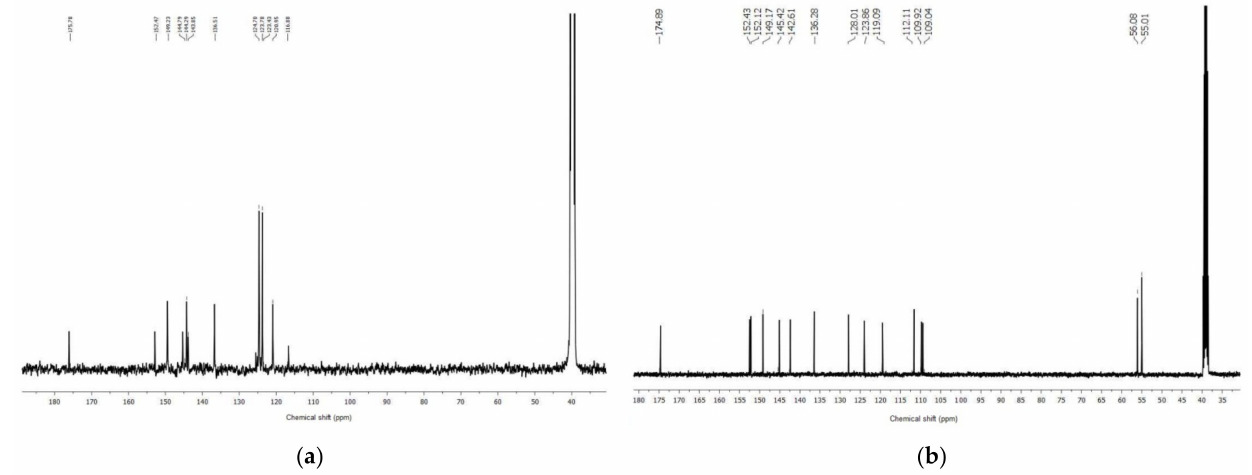
Figure 3. 13 C NMR spectra of HL 1 ( a ) and HL 2 ( b ) measured in DMSO-d 6